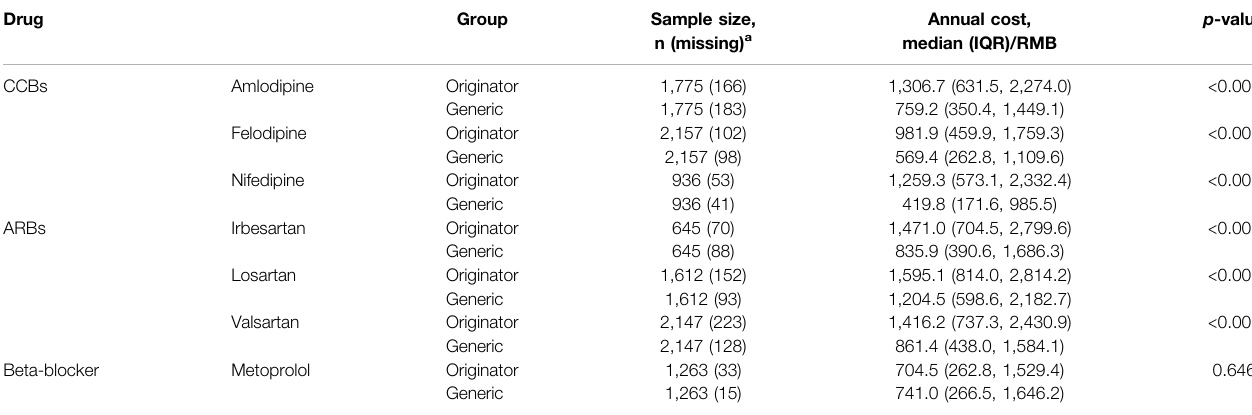
p -value Annual cost, n (missing) a median (IQR)/RMB